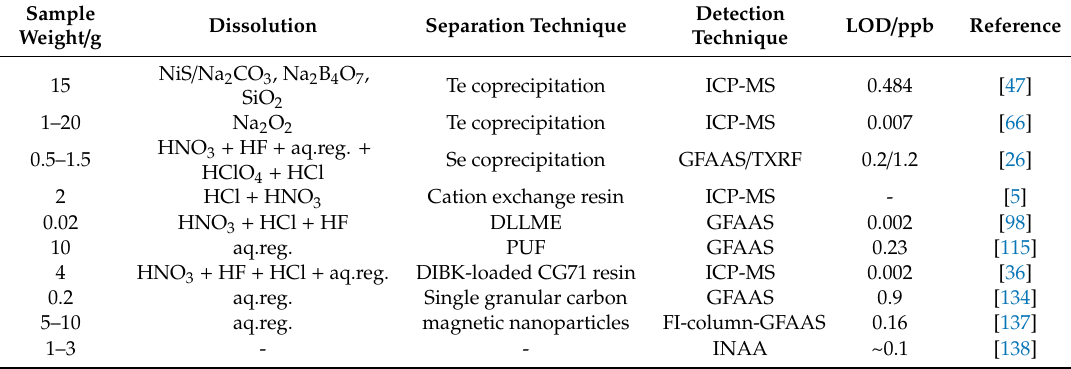
Table 7. Various analytical methods commonly used for the gold determination in rocks. Sample Weight /